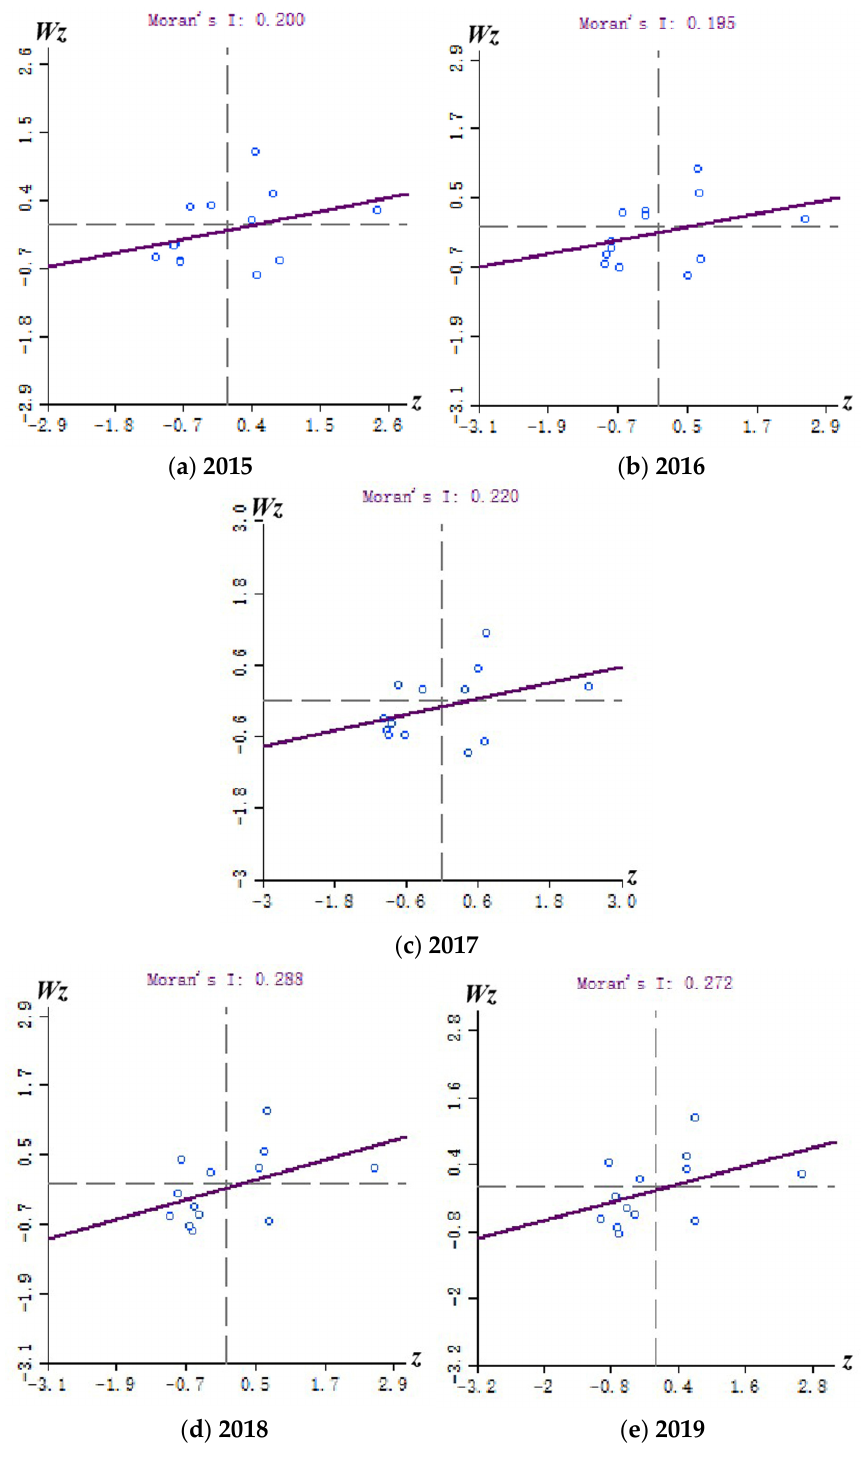
Figure 5. The Moran scatter plot of the local autocorrelation of medical and health services efficiency in Jiangsu Province from 2015 to 2019.